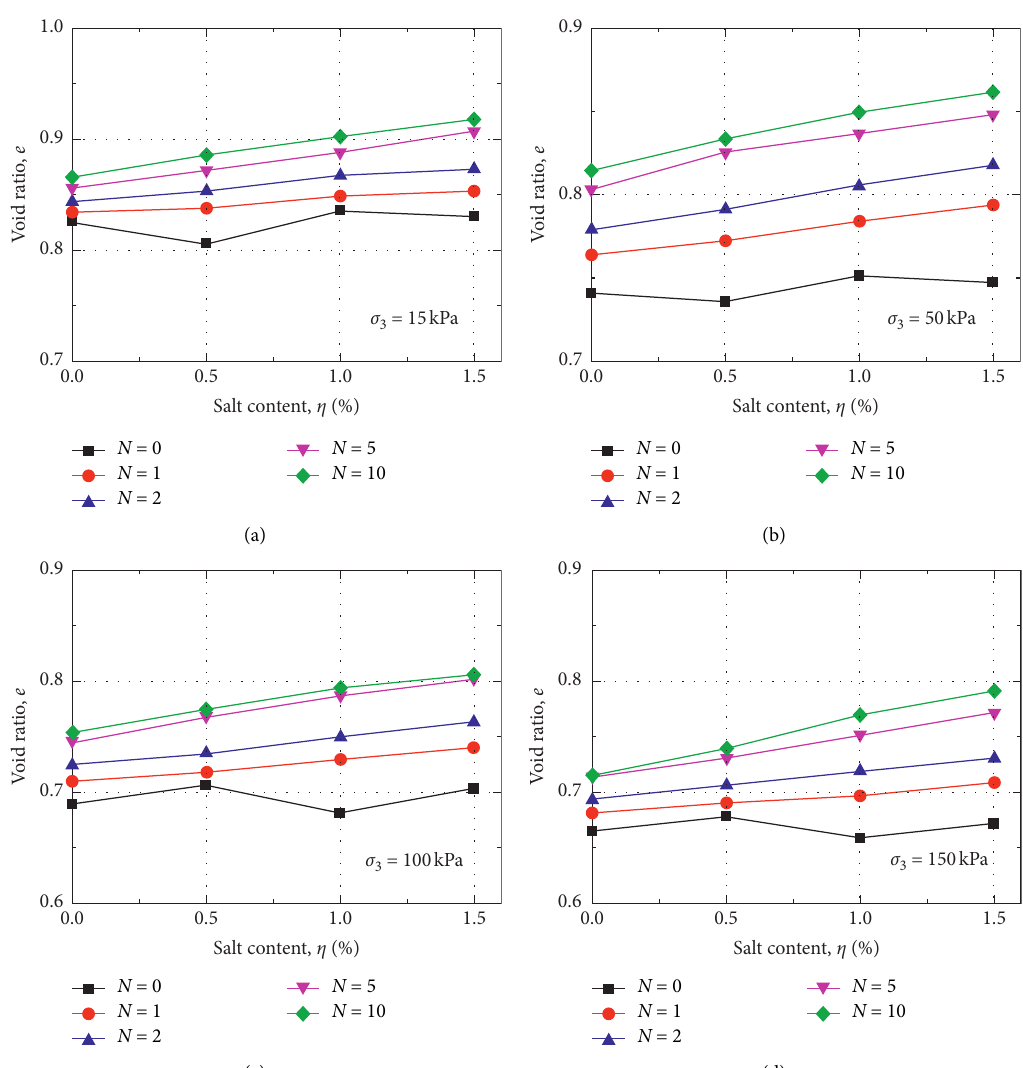
Figure 8: The void ratio of saline intact loess at various salt